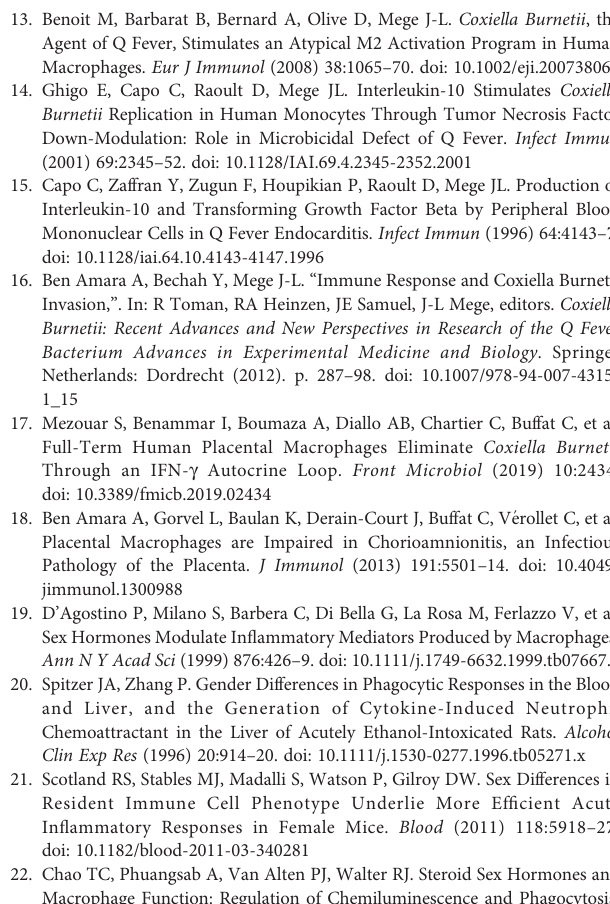
Supplementary Figure 5 | Role of sex hormones in MDM responses to C. burnetii. MDMs from healthy donors from males (n=3) and females (n=3)